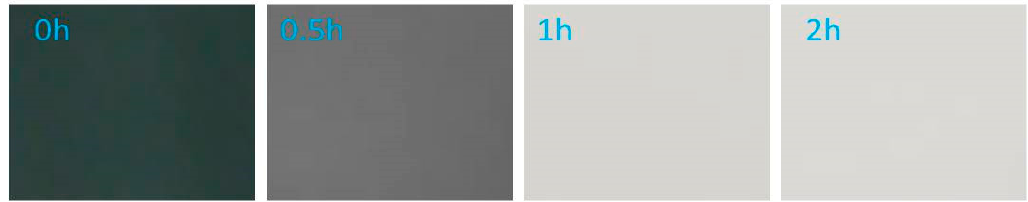
Figure 13. Residual concentration (%) and pH for System 5, as a function of the UV irradiation time exposure.